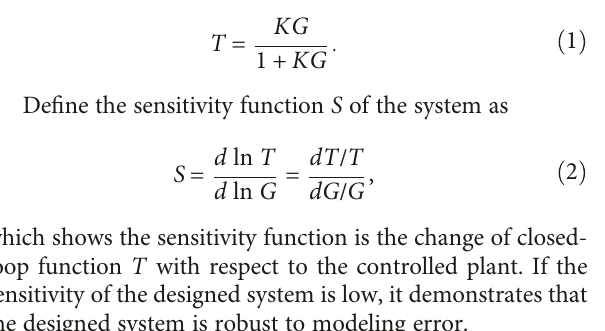
Figure 2: Nyquist curve of a system.